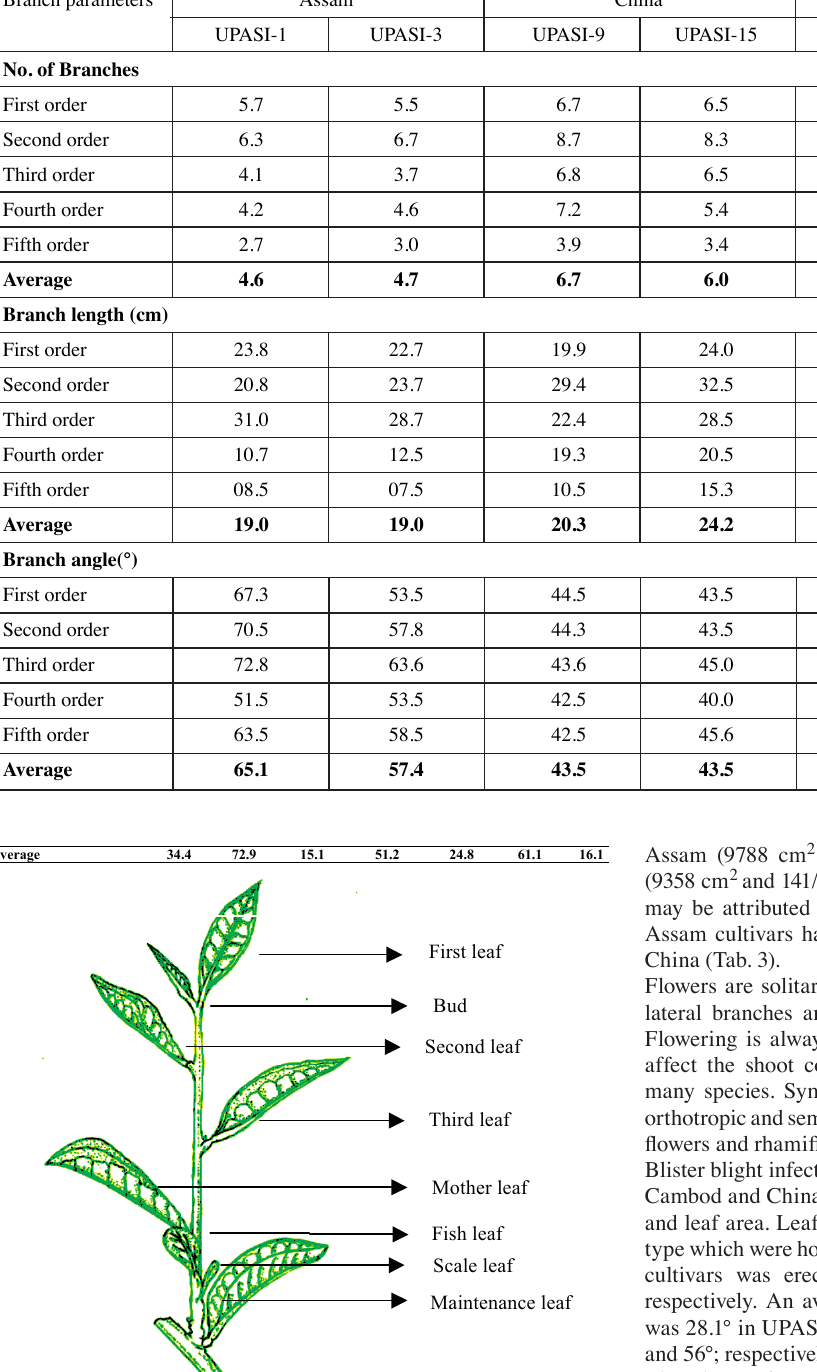
First order lateral